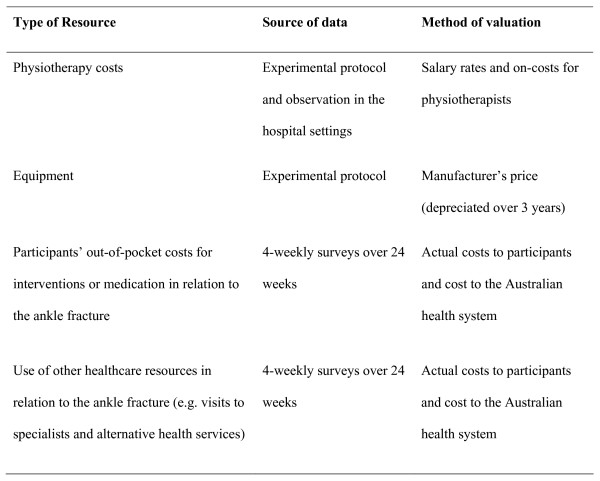
Economic evaluation